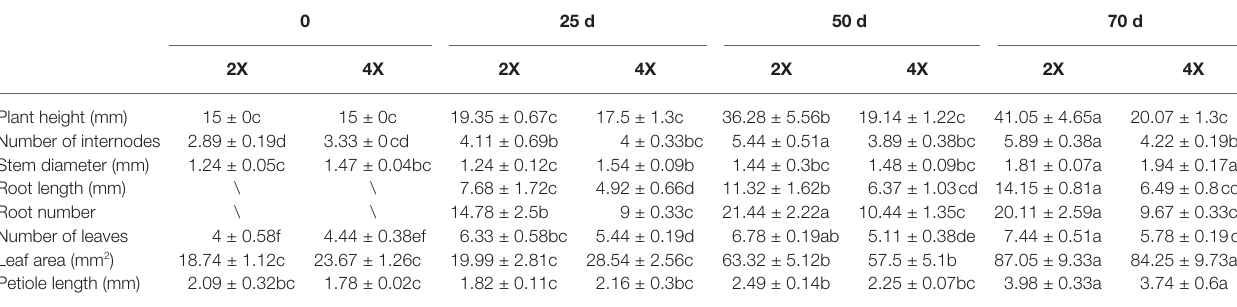
TABLE 1 | In vitro growth statistics of diploid and tetraploid hybrid sweetgum plants at various developmental